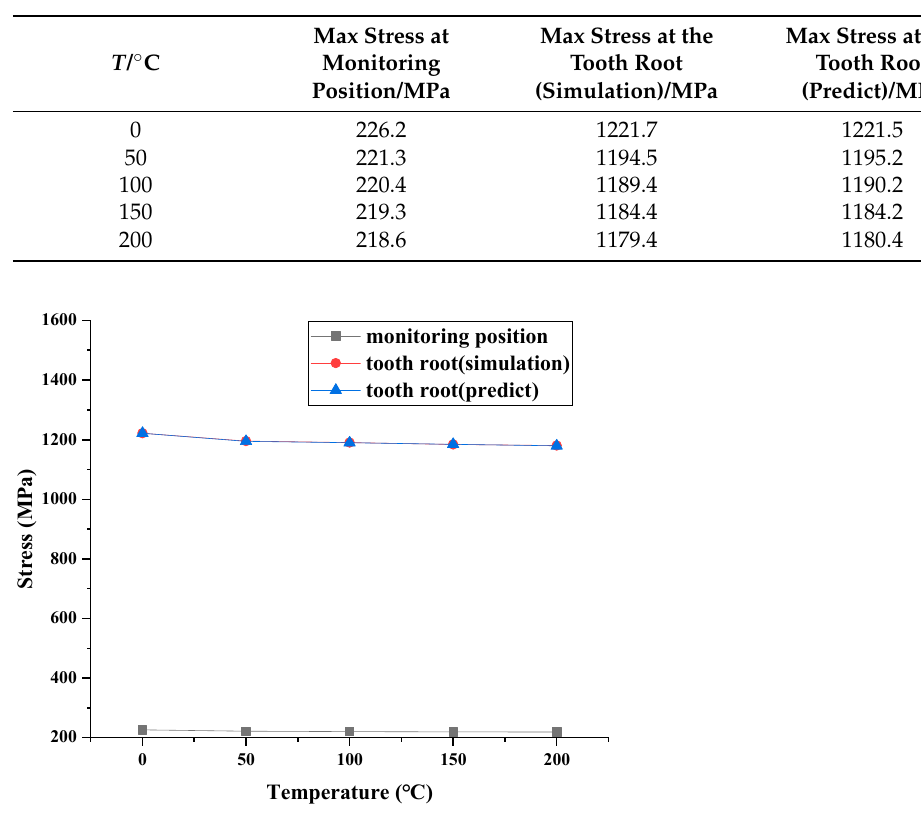
Table 14. Stress at the monitoring position and the tooth root at 4th ND resonant rotational speed at different temperatures.